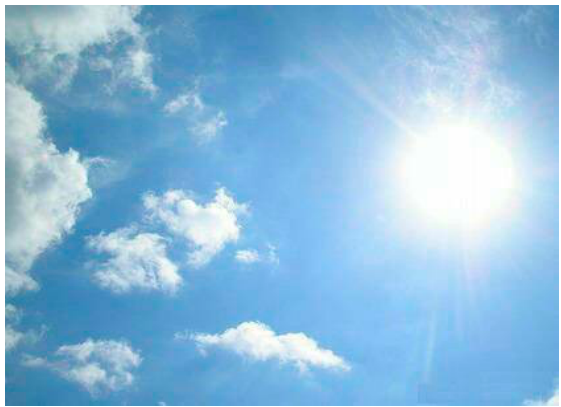
Figure 1. The color image of a sunny sky image.